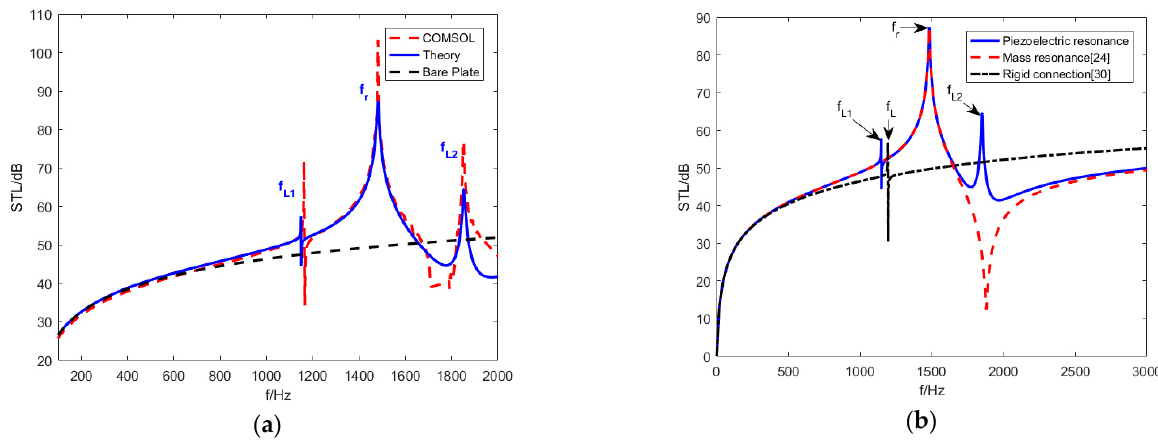
12 of 23 Figure 11. Effective dynamic mass–density curve. Figure 10a,b show the effective bending stiffness becomes negative when piezoelec- tric resonance frequency 𝑓 (cid:2896)(cid:2869) equals 1147 Hz or 𝑓 (cid:2896)(cid:2870) equals 1849 Hz , which cause the voltage peaks because of the electromechanical coupling. Figure 11 represents the effec- tive mass density becomes negative when mass resonance frequency 𝑓 (cid:2928) equals 1481 Hz . Negative effective bending stiffness and negative effective mass density are achieved. Figure 12a shows the theoretical numerical results and finite element simulation re- sults. Due to the negative bending stiffness and density, as per the STL curves, three STL peaks are achieved at 𝑓 (cid:2896)(cid:2869) , 𝑓 (cid:2896)(cid:2870) and 𝑓 (cid:2928) , and the STL near the resonant frequencies is signifi- cantly better than the plate with the same weight. Figure 12b reproduces the STL of met-